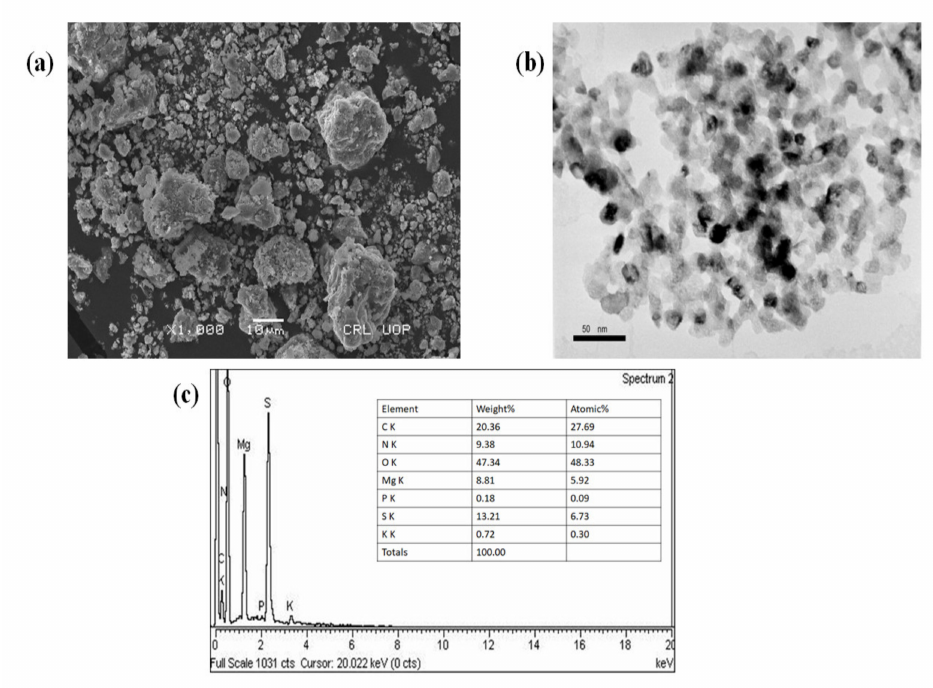
Figure 3. ( a ) SEM micrograph, ( b ) TEM micrograph and ( c ) EDX analysis of